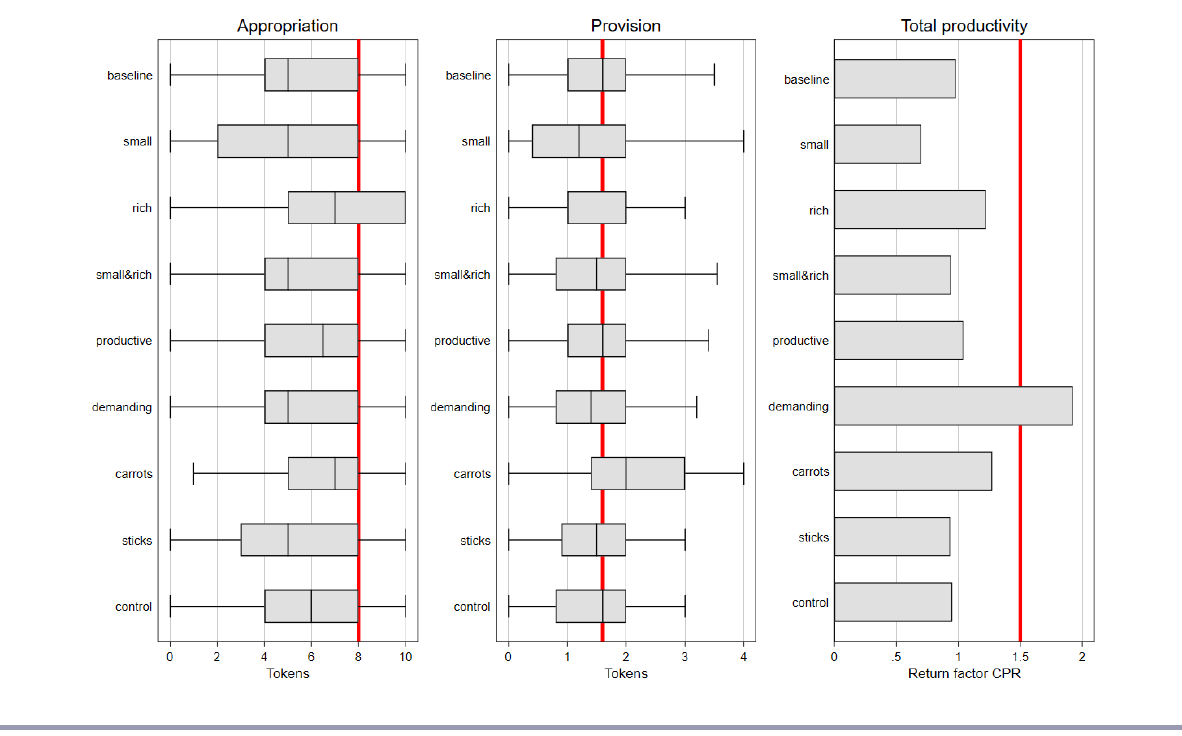
Fig. 2. Appropriation and provision levels, and resource productivity for a baseline situation and eight treatments. The red reference lines indicate the optimum for appropriation, provision levels, and the initial resource productivity. Note: normalized values displayed in the appropriation graph for the “rich” and “small–rich” treatments and for the “demanding” and “productive” treatments are in the provision